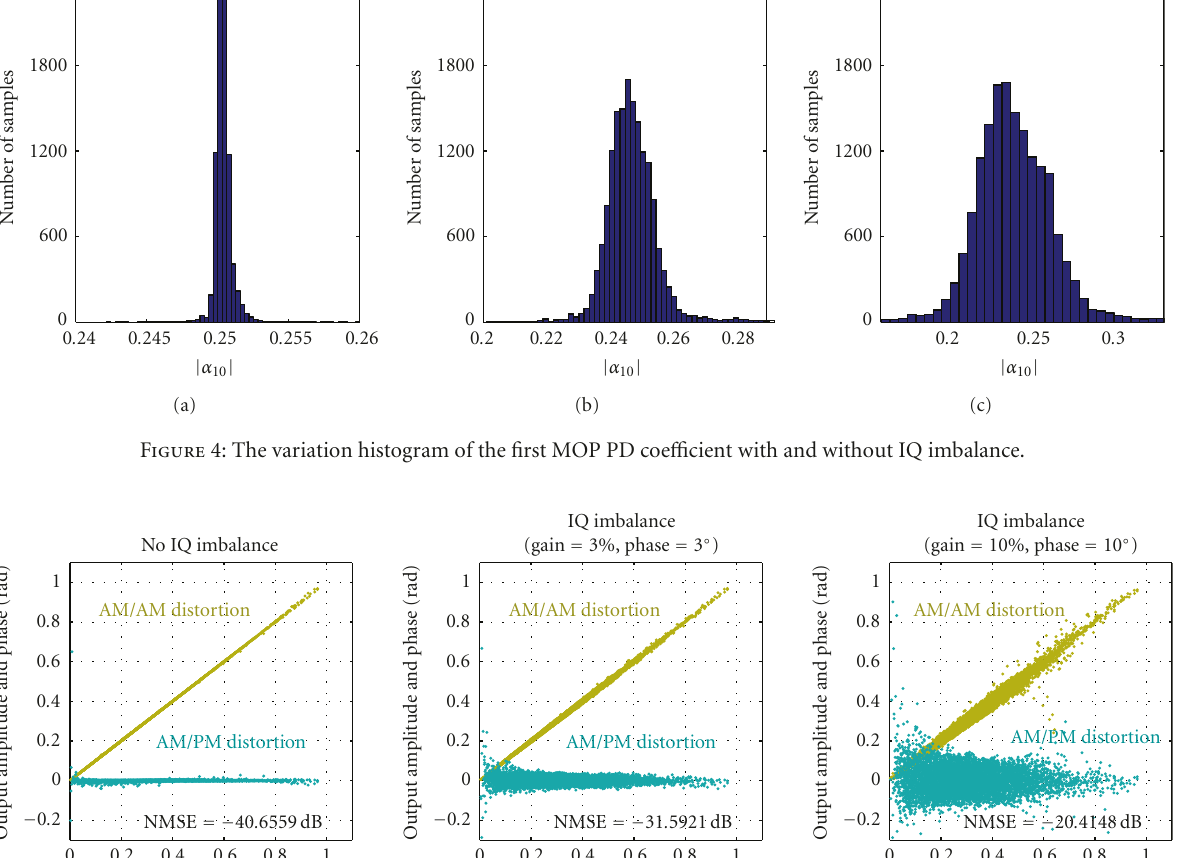
0.7% without IQ imbalance to approximately 2.2% and